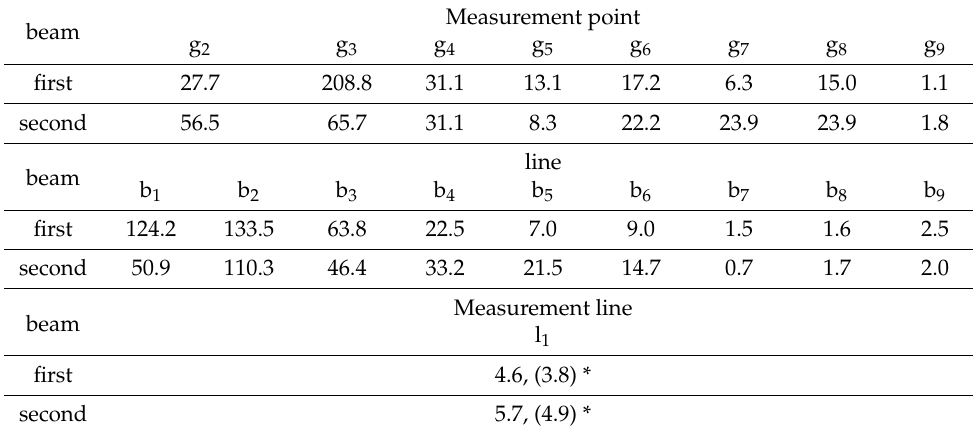
Table 4. The ratio of the unit loss of thickness, width, and length of chisels B in relation to the wear of chisels